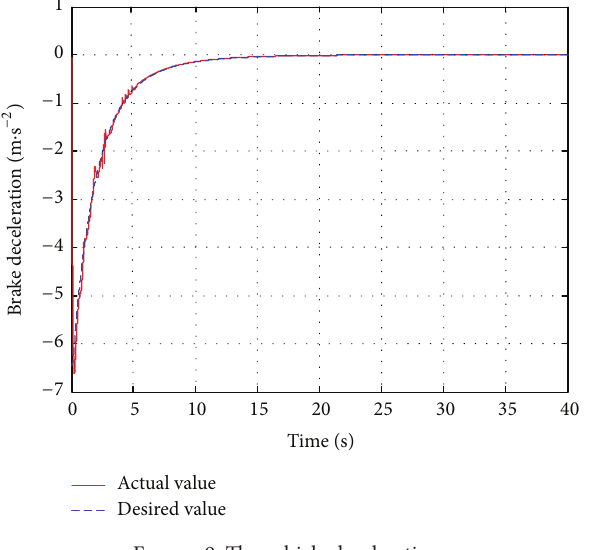
Figure 11: The relative distance.